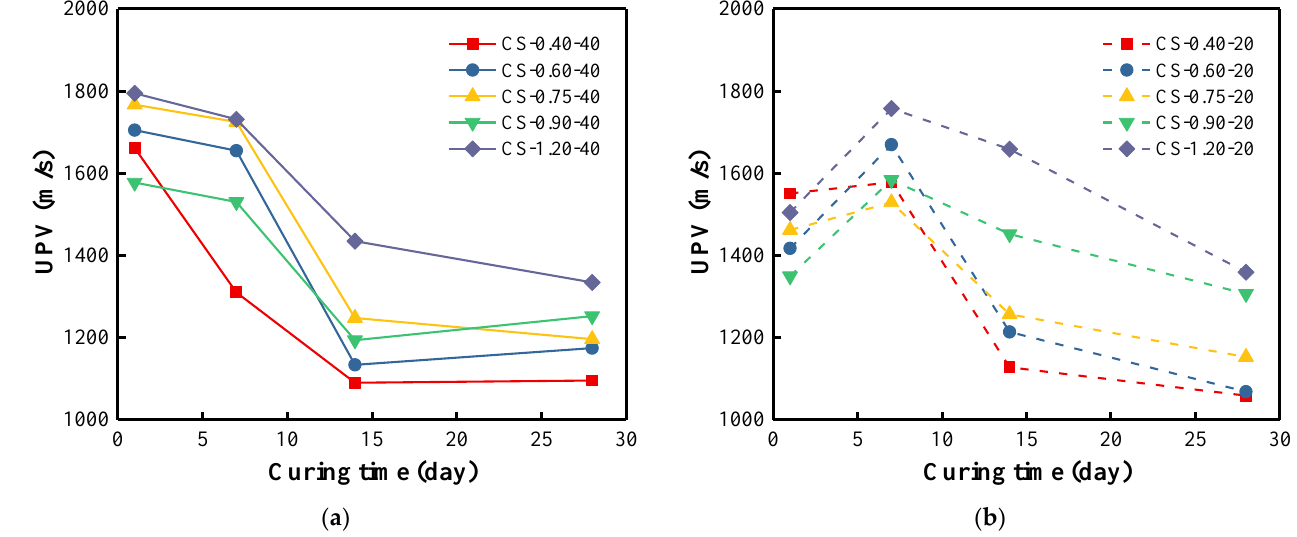
Figure 12. UPV of BFA-based AAM pastes cured at ( a ) 40 ◦ C and ( b ) 20 ◦ C for 28